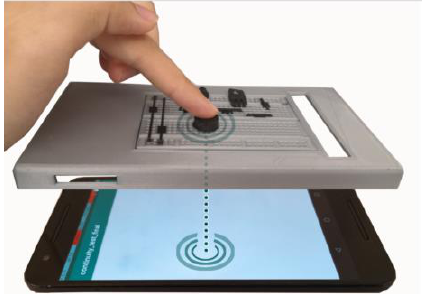
Figure 10. Printed TangibleCircuits with an audio interface on a smartphone [24].